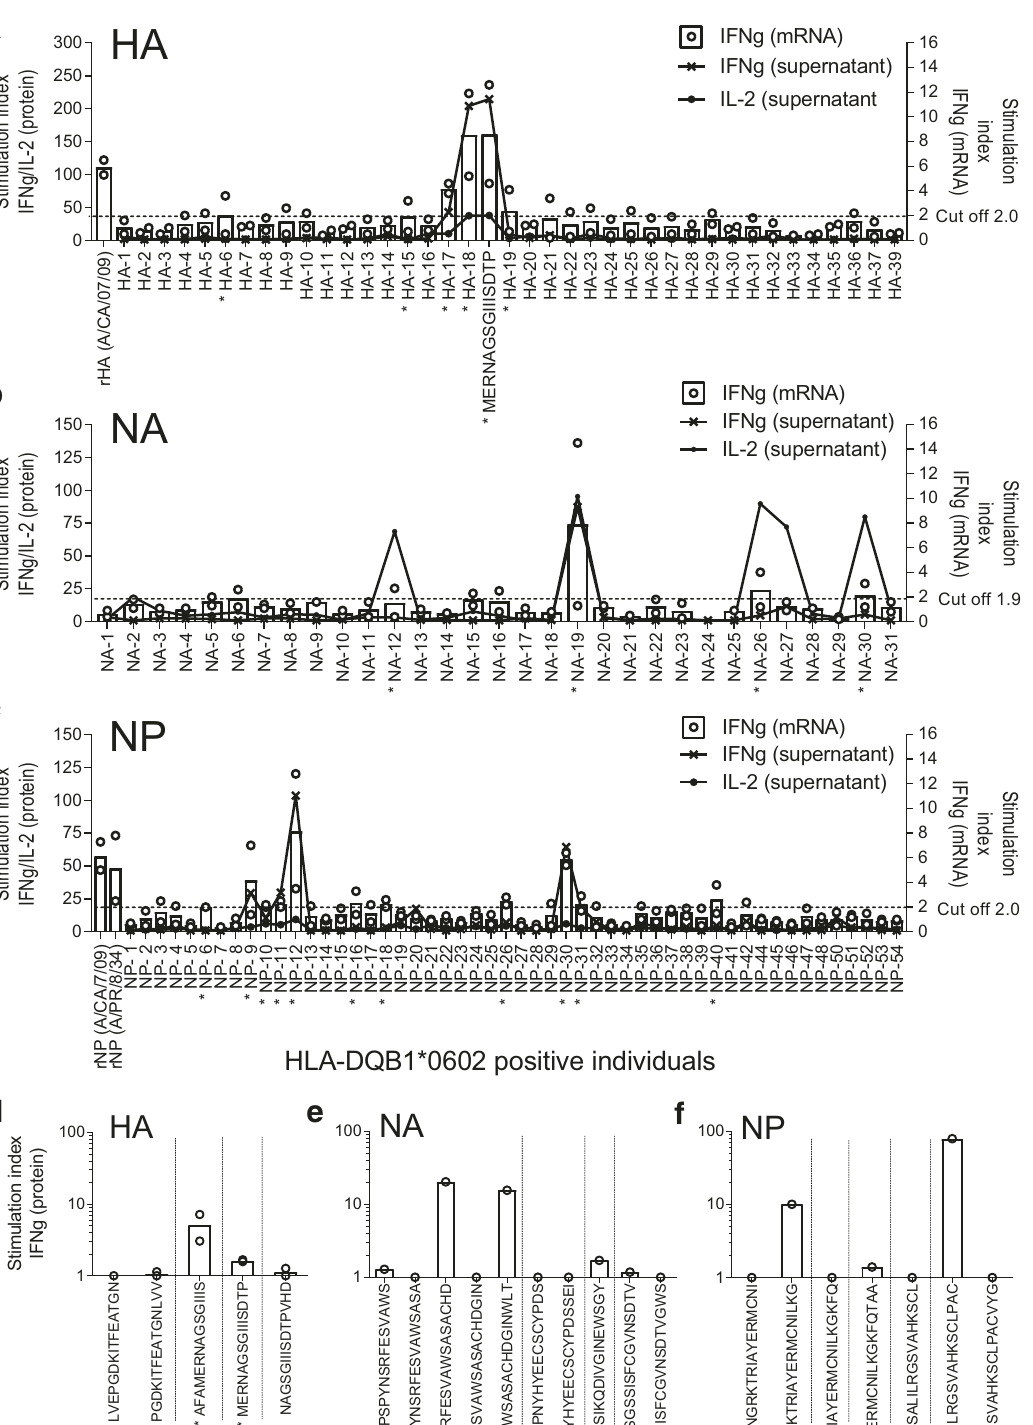
and sort strategy shown in Supplementary Fig. 7). Overall, gene expression in the NA 175 – 189 -stimulated CD8 + T-cell sample matched the pro fi le obtained from NA 175 – 189 -stimulated PBMC, suggesting that peptide NA 175 – 189 might be presented by both HLA class I and II. This fi nding was also consistent with the notion that cytotoxic T-cells are a key effector cell population mediating immunity against in fl uenza A virus 20